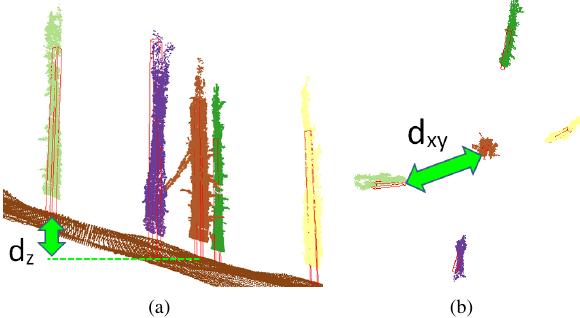
Figure 4: Tree stems on DTM with marked stem descriptor dis- tances. (a) side view - Z distance, (b) top view - XY